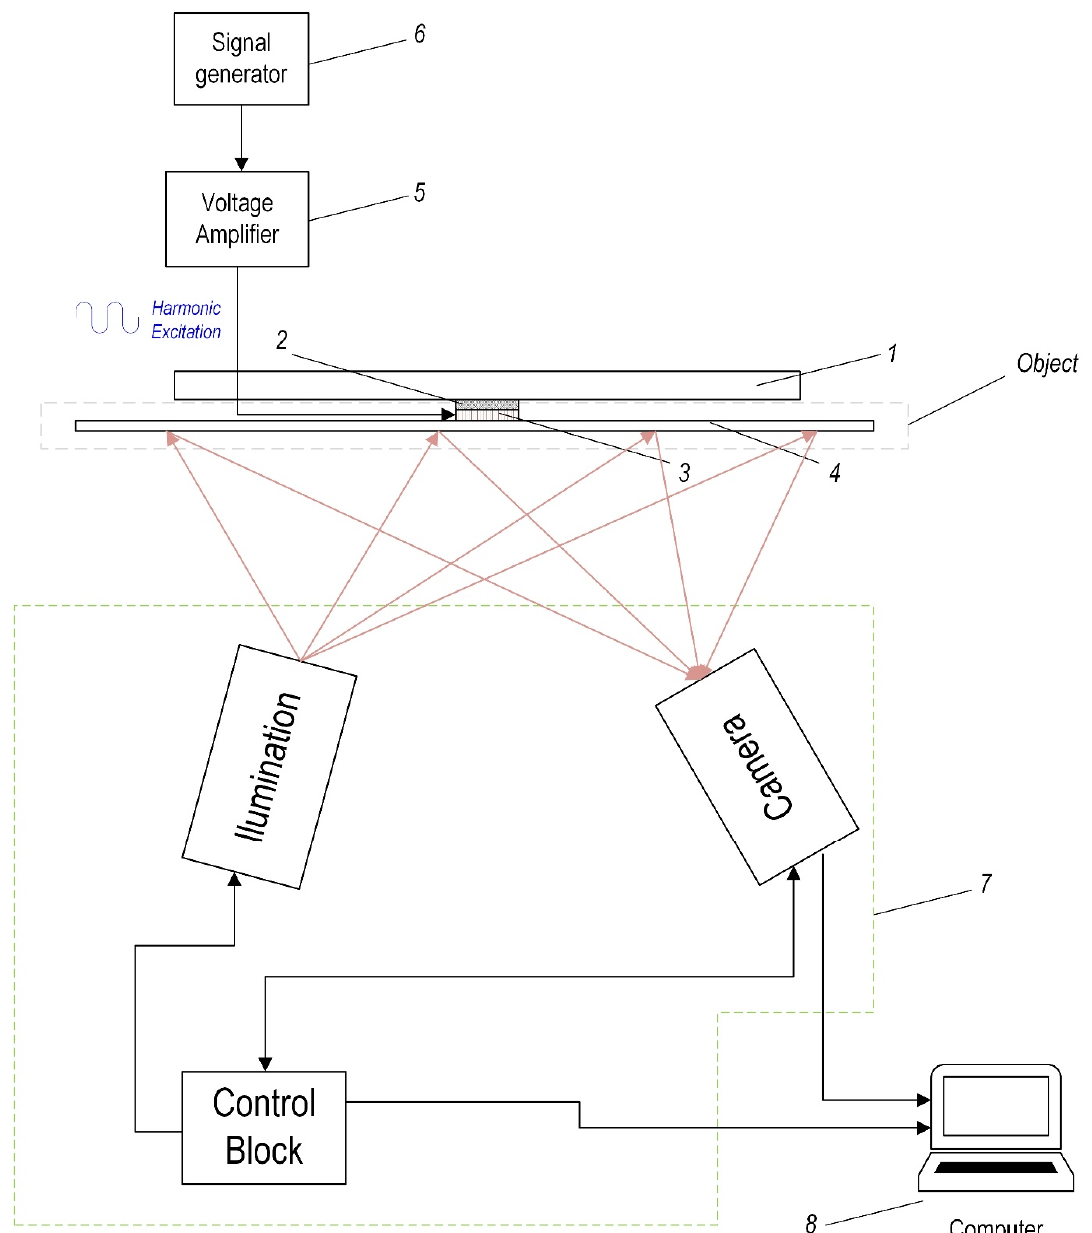
Figure 8. Scheme of holographic experimental set-up: 1—aluminum base (perpendicular to illumination and camera), 2—soft isolation layer, 3—piezoelectric transducer–actuator (for excitation), 4—composite plate, 5—voltage amplifier EPA 104, 6—signal generator Tabor WW5064, 7—holographic system PRISM, 8–PC.